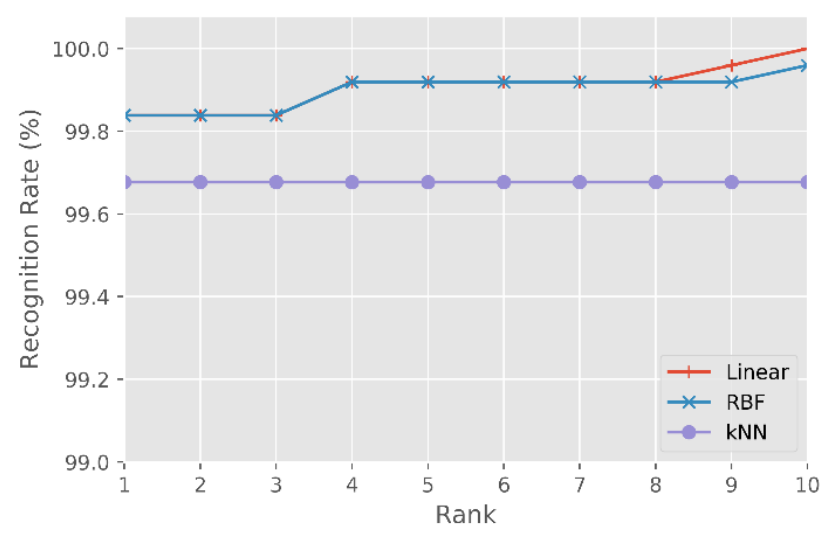
Figure 8. CMC curve for the SVM-Linear, SVM-RBF and kNN classifiers, for the CASIA NIR-VIS 2.0 test set.